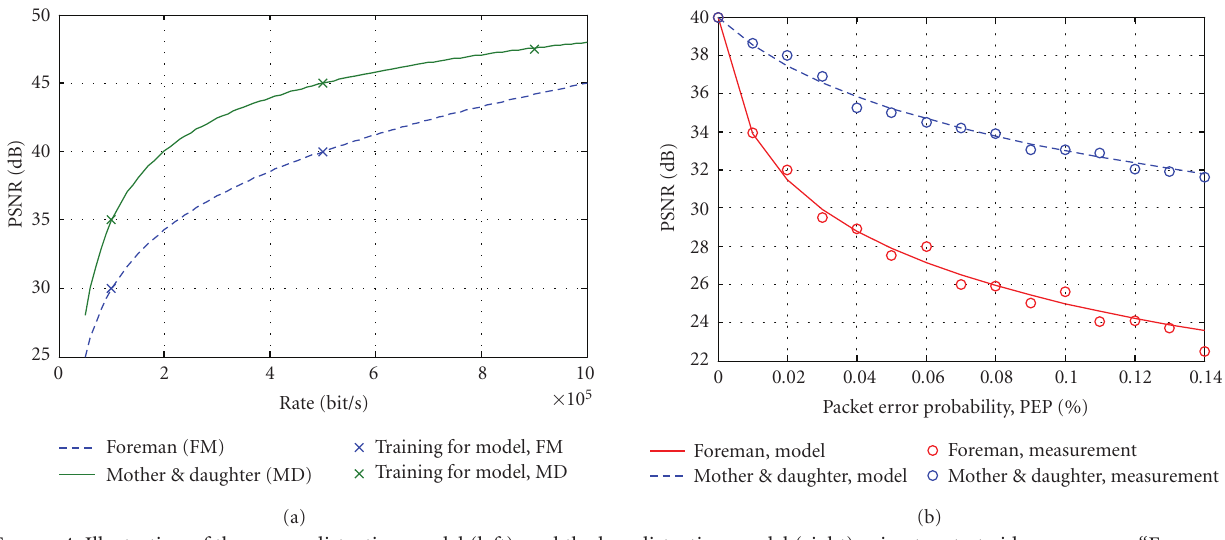
Figure 4: Illustration of the source distortion model (left), and the loss distortion model (right) using two test video sequences “Foreman” and “Mother and Daughter.”